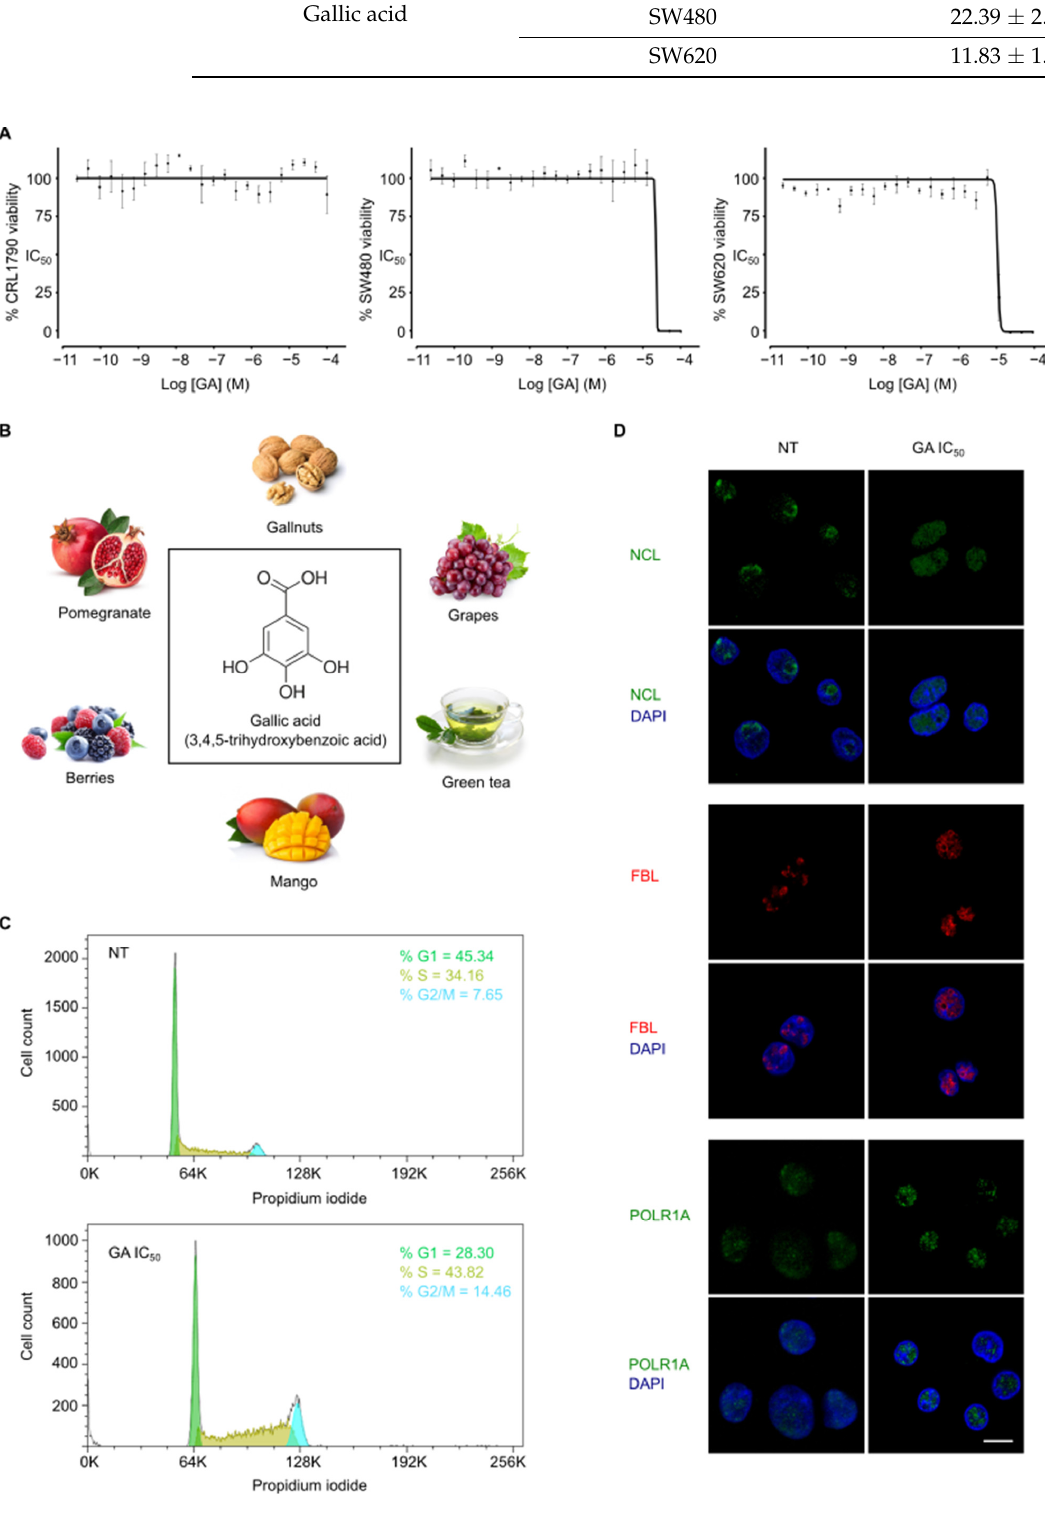
Figure 1. Gallic acid induces cell cycle arrest and nucleolus disintegration. ( A ) Dose response curve of GA for non-tumoral CRL1790, tumoral SW480 and metastatic SW620 cells after treatment during 48 h. ( B ) Chemical structure of GA selected as antitumoral candidate and natural sources where it can be found. ( C ) Histograms of SW480 cells treated with DMSO (non-treated, NT) or treated with GA IC 50 for 24 h in propidium iodide flow cytometry analysis. ( D ) Immunofluores- cence images of SW480 cells treated with vehicle DMSO (NT) or treated with GA IC 50 for 6 h, and